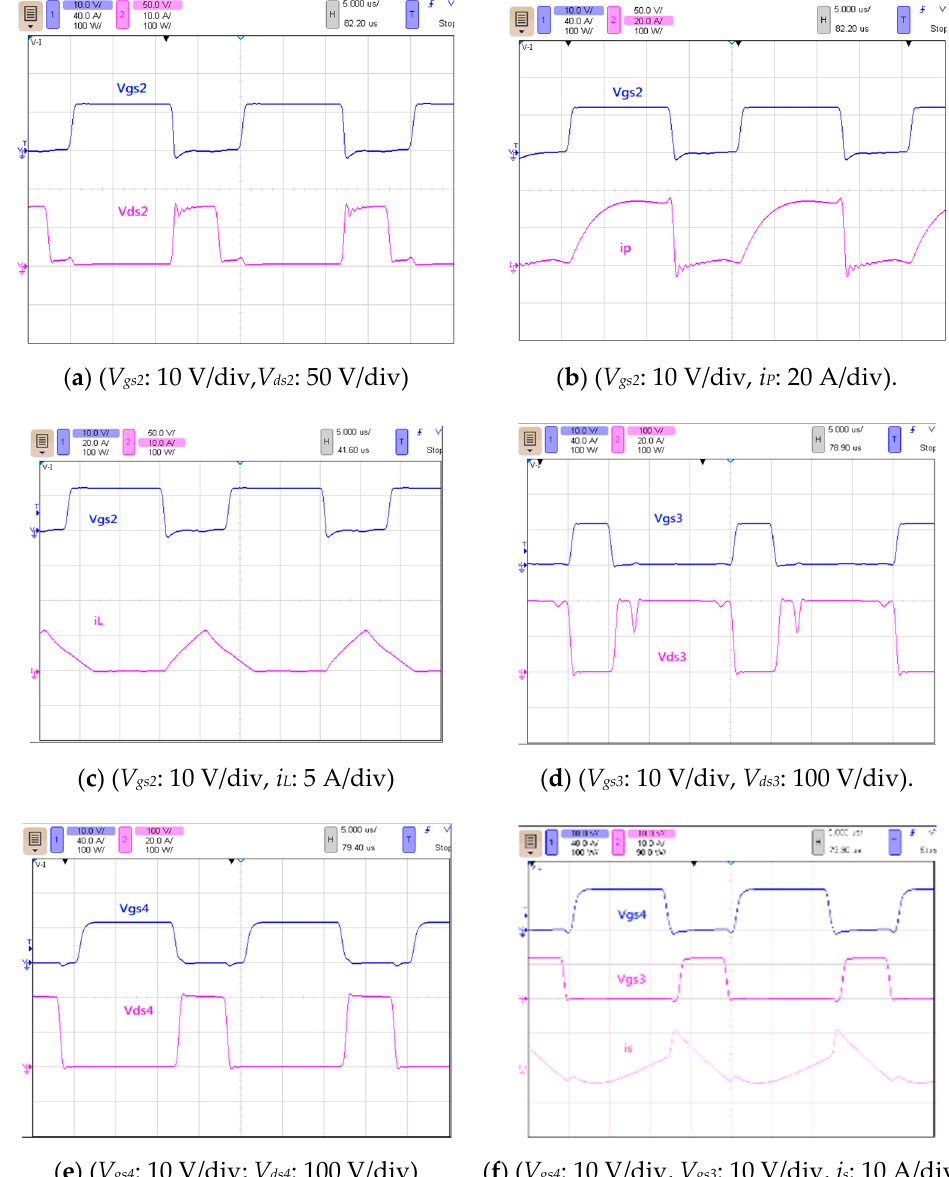
Figure 10. Measured waveforms under Stage 1 at full load: ( a ) switch S 2 waveform, ( b ) primary-side current waveform of transformer, ( c ) charging inductor current waveform, ( d ) switch S 3 waveform, ( e ) switch S 4 waveform, and ( f ) secondary-side current waveform of transformer.